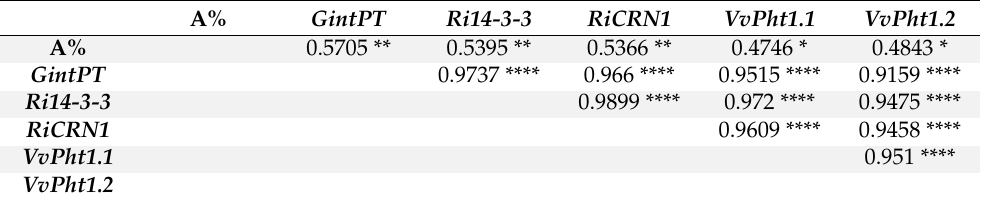
Table 3. Spearman’s rank correlation coefficients between expression of Rhizophagus irregularis or plant genes and arbuscule abundance in the whole root system (A%).